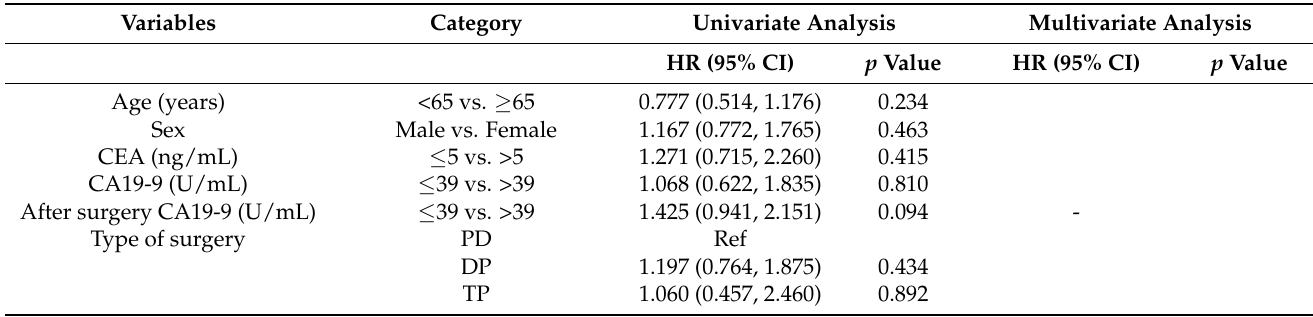
Figure 5. A 61-year-old man was found to have a tumor with a head size of about 2.1 cm in the pancreas, which was pathologically confirmed to be pancreatic ductal adenocarcinoma after surgery; we found that the tumor was characterized by a low ADC value, low D value, and high f value after quantitative MRI measurement. He was found to have a local recurrence at follow up 9 months after surgery and died 15 months later. MRI T2 ( a ), DWI ( b ), and ADC map ( c ) showed solid mass in the head of pancreas measured ADC measurements of 1.07 × 10 − 3 mm 2 /s, D value of 0.91 × 10 − 3 mm 2 /s, and f value of 0.47. Immunohistochemical staining showed an abundance of CAFs in the stroma (( d ) α -SMA, × 10), carcinoma cells with higher expression of VEGF in the cytoplasm (( e ) VEGF, × 10), and HIF-1a in the nuclear (( f ) HIF-1 α , × 20). These findings suggested that the tumor microenvironment was active with a higher hypoxia level. Table 2. Cox Survival Analysis of Predictors of Overall